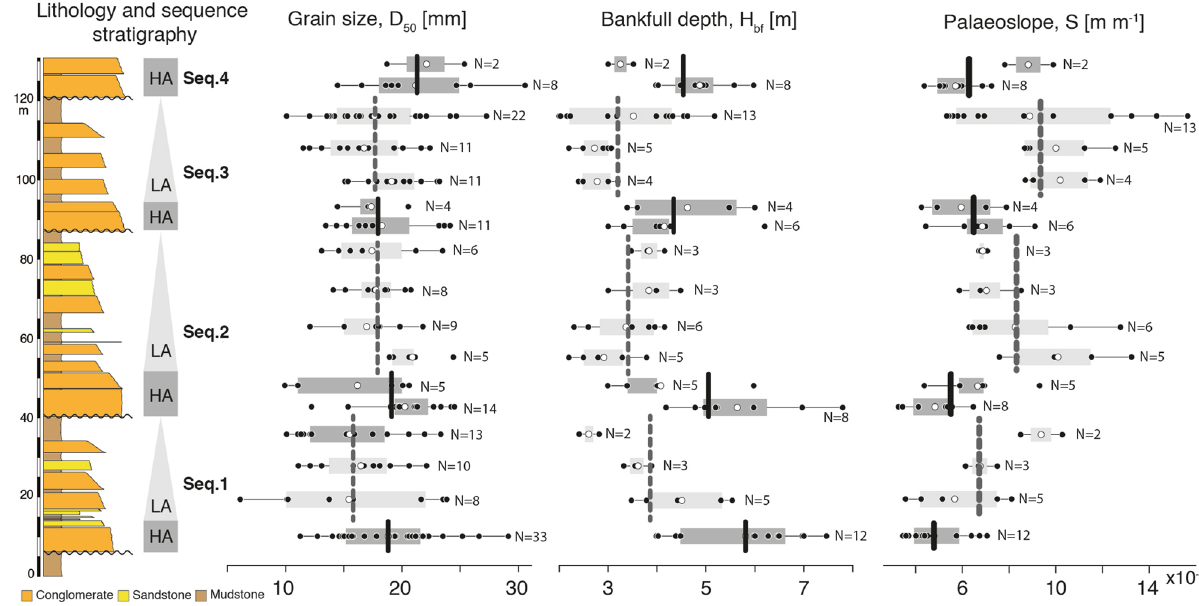
Figure 5. Grain-size, flow depth and palaeoslope evolution as a function of the degree of amalgamation. Stratigraphic log of the studied section depicting the three studied fining-upward HA-LA sequences. The calibration to the geomagnetic polarity timescale 2016 42,43 is shown to the left. Median grain size, D 50 [mm], channel bankfull depth, H bf [m], and channel bed palaeoslope, S [m/m], are shown for each sampled fluvial storey. Black vertical bars denote the average value in HA intervals while grey bars denote the average value in LA intervals.